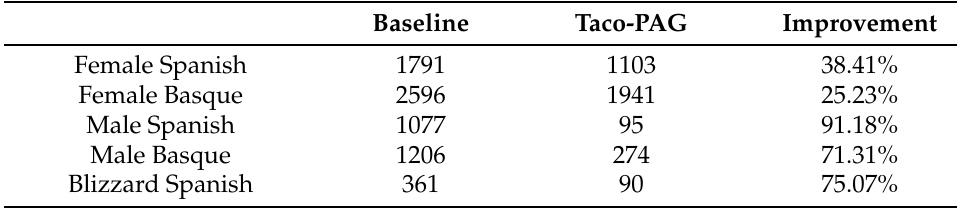
Table 3. Number of utterances with errors and relative improvement in